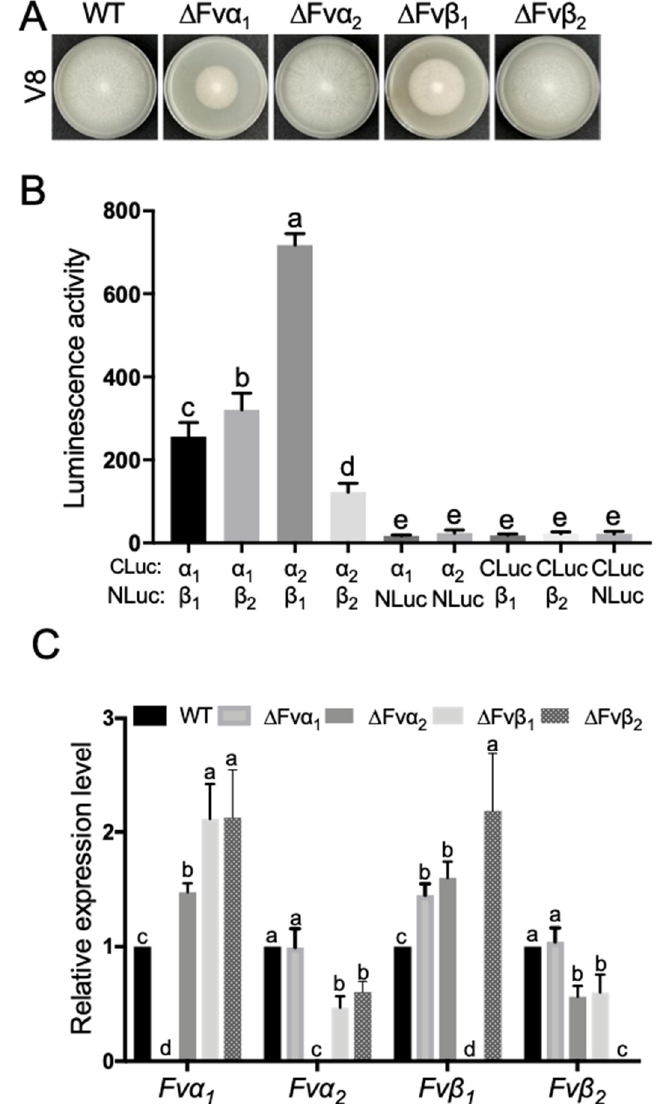
Figure 7. Growth and gene interaction assays using four microtubule deletion mutants. ( A ) WT, Δ Fv α 1 , Δ Fv α 2 , Δ Fv β 1 , and Δ Fv β 2 strains were cultivated on V8 plates. ( B ) Luminescence activity was obtained from three replicates. Multiple negative controls (Fv α 1 -Cluc + NLuc, Fv α 2 -Cluc + NLuc, NLuc + Fv β 1 -CLuc , NLuc + Fv β 2 -CLuc, NLuc-CLuc) were included in the study. Different letters on the bars indicated significance according to prism Ordinary one-way ANOVA multiple comparisons at p < 0.05. ( C ) Fv α 1 , Fv α 2 , Fv β 1 , and Fv β 2 relative expression in WT, Δ Fv α 1 , Δ Fv α 2 , Δ Fv β 1 , and Δ Fv β 2 strains were determined by RT-qPCR. Significant differences were indicated with different letters on the bars according to prism two-way ANOVA at p < 0.05.